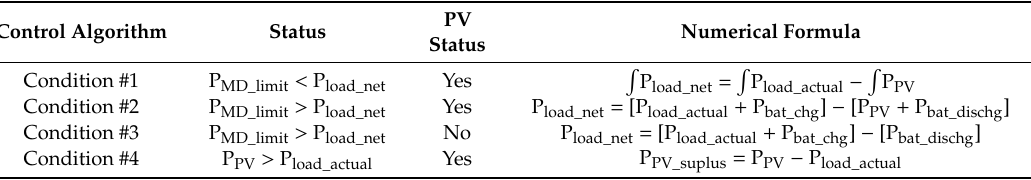
Table 11. Summary of validation data at 750 kW MD limit setting.